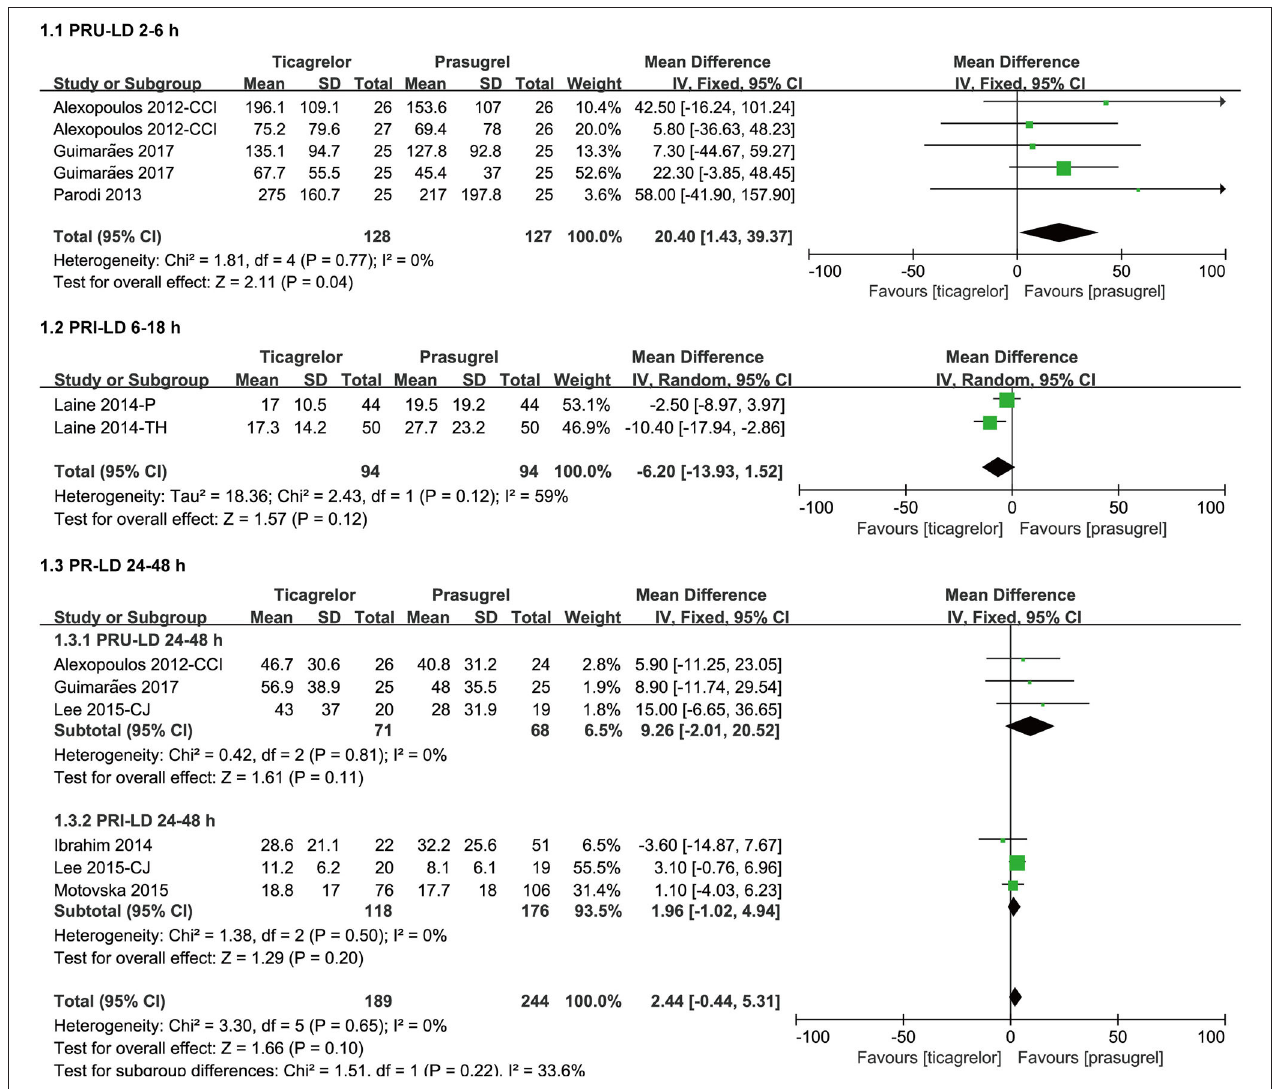
FIGURE 4 | Forest plots of meta-analysis results of PR after